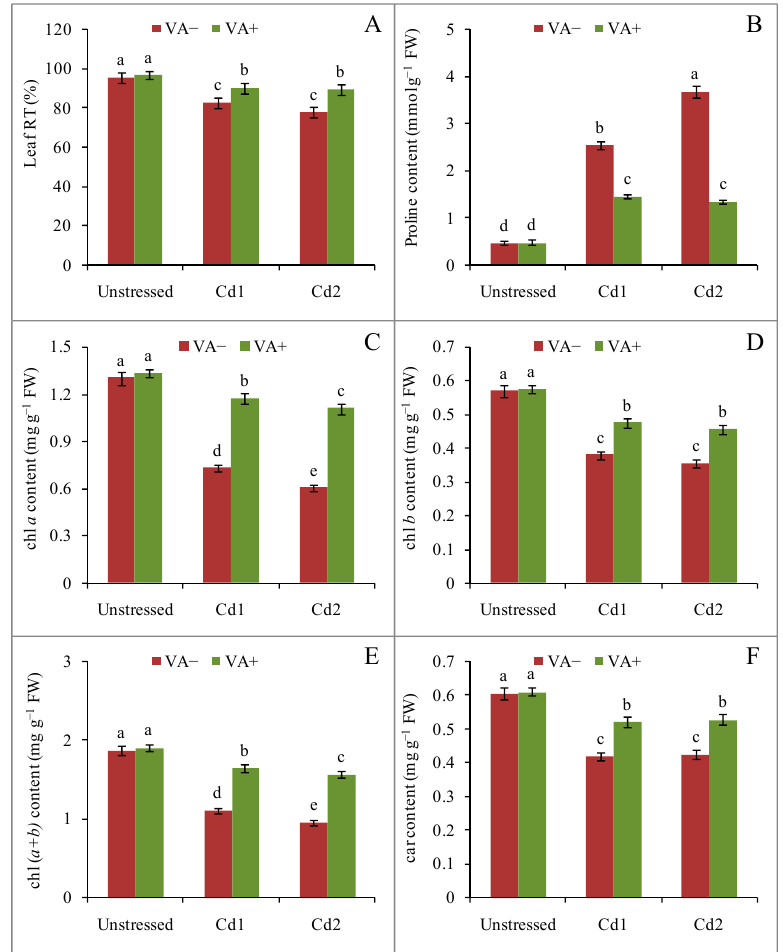
Figure 3. Effects of exogenous VA on leaf turgidity (RT) (%) ( A ), pro content ( B ), chlorophyll (chl) a ( C ), chl b ( D ), chl ( a + b ) ( E ), and carotenoid (car) ( F ) contents of rice ( Oryza sativa L. cv. BRRI dhan54) seedlings under Cd toxicity stress. Mean (± SD) was computed from three replications of each treatment. Bars with dissimilar letters are significantly different at p ≤ 0.05 from Fisher’s least significant difference (LSD) test .